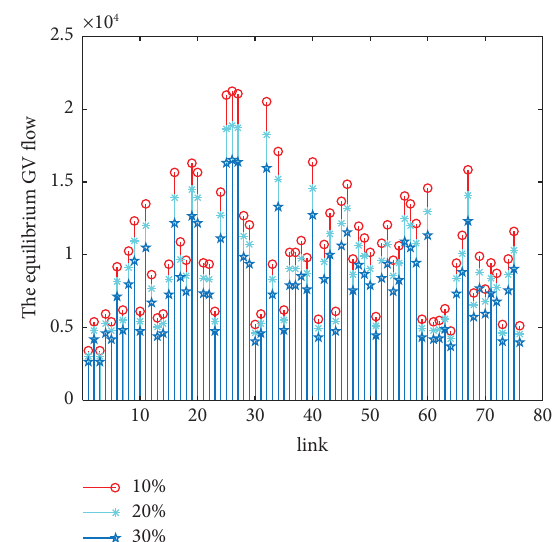
Figure 5: Te equilibrium GV fow under diferent BEV market shares.